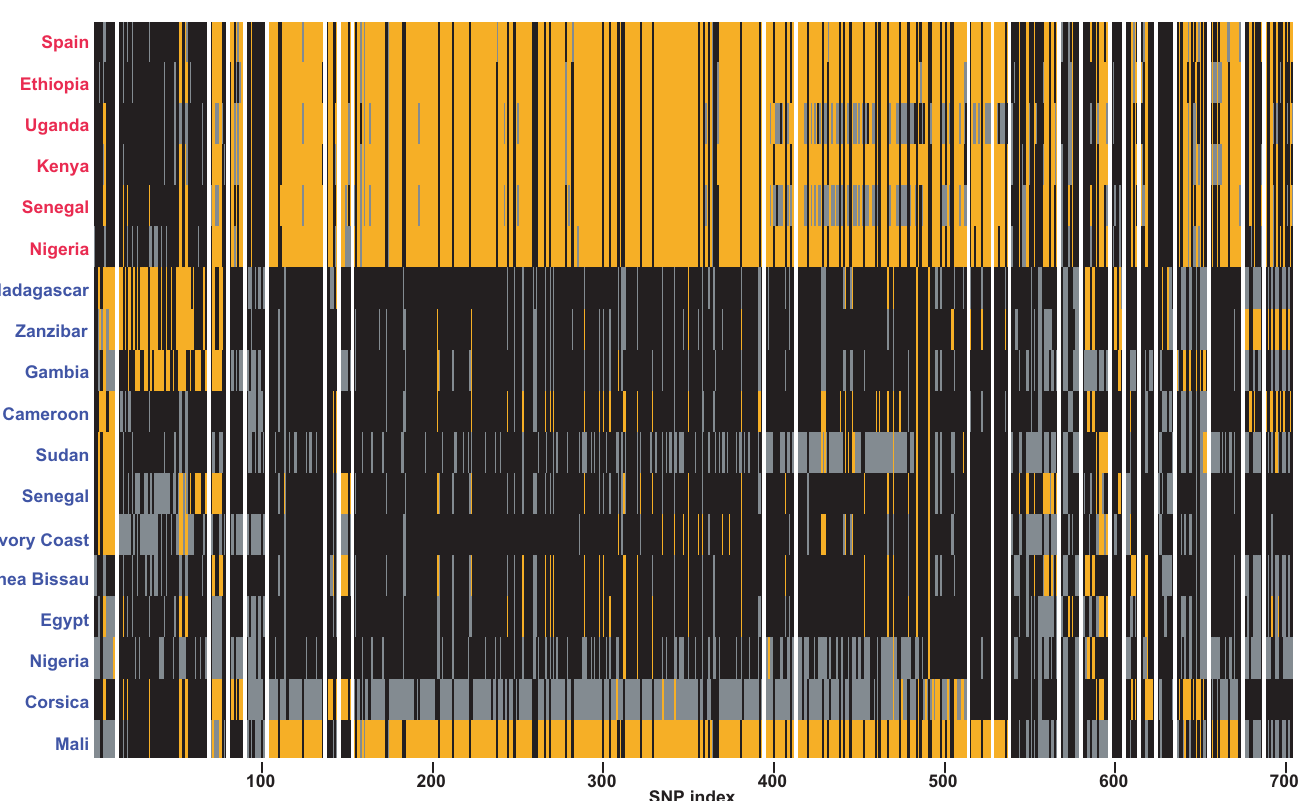
Fig 3. Representation of the allelic state of each isolate at each SNP (N = 705) along the S . bovis -like genomic tracts detected in at least one S . haematobium isolate N = 24). Each vertical bar represents a single SNP position. SNPs at which isolates are homozygous and harboring an allele identical or different to the genome of reference (Egyptian strain) [41] are in black and orange respectively. SNPs at which isolates are heterozygous are in grey. Independent genomic tracts along scaffolds are separated by a vertical white line. Individuals initially characaterised as S. bovis and S. haematobium are in red and blue respectively.